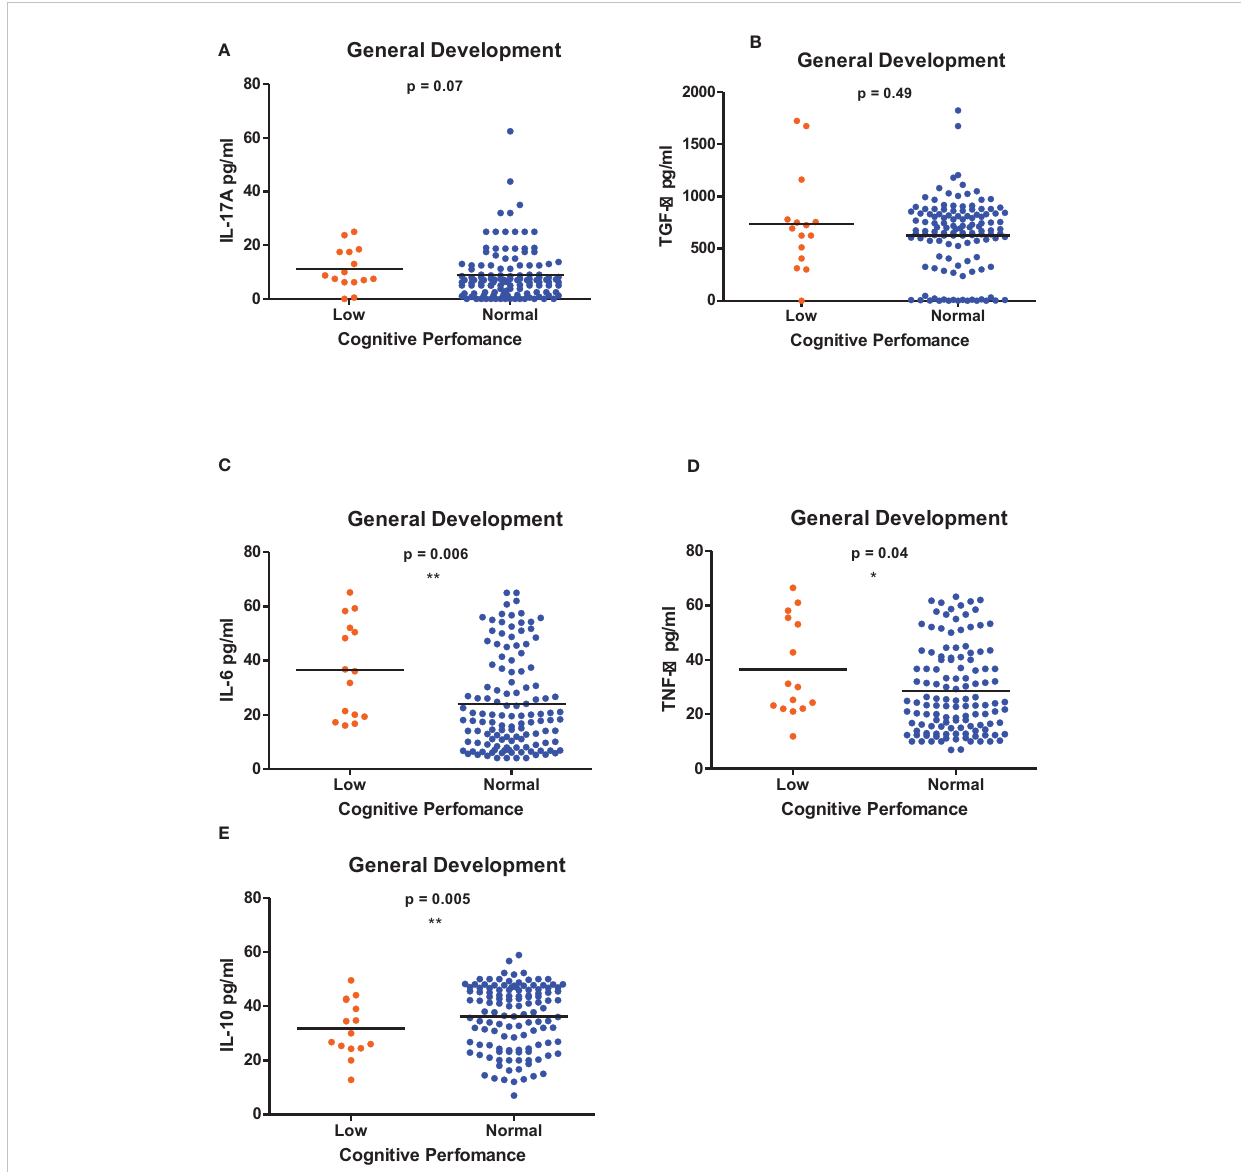
FIGURE 6 (A-E) Cytokine concentration level comparisons between low and normal PSAC performers in the General Development Domain using the Wilcoxon matched-pairs signed rank test. * = p ≤ 0.05, ** = p ≤